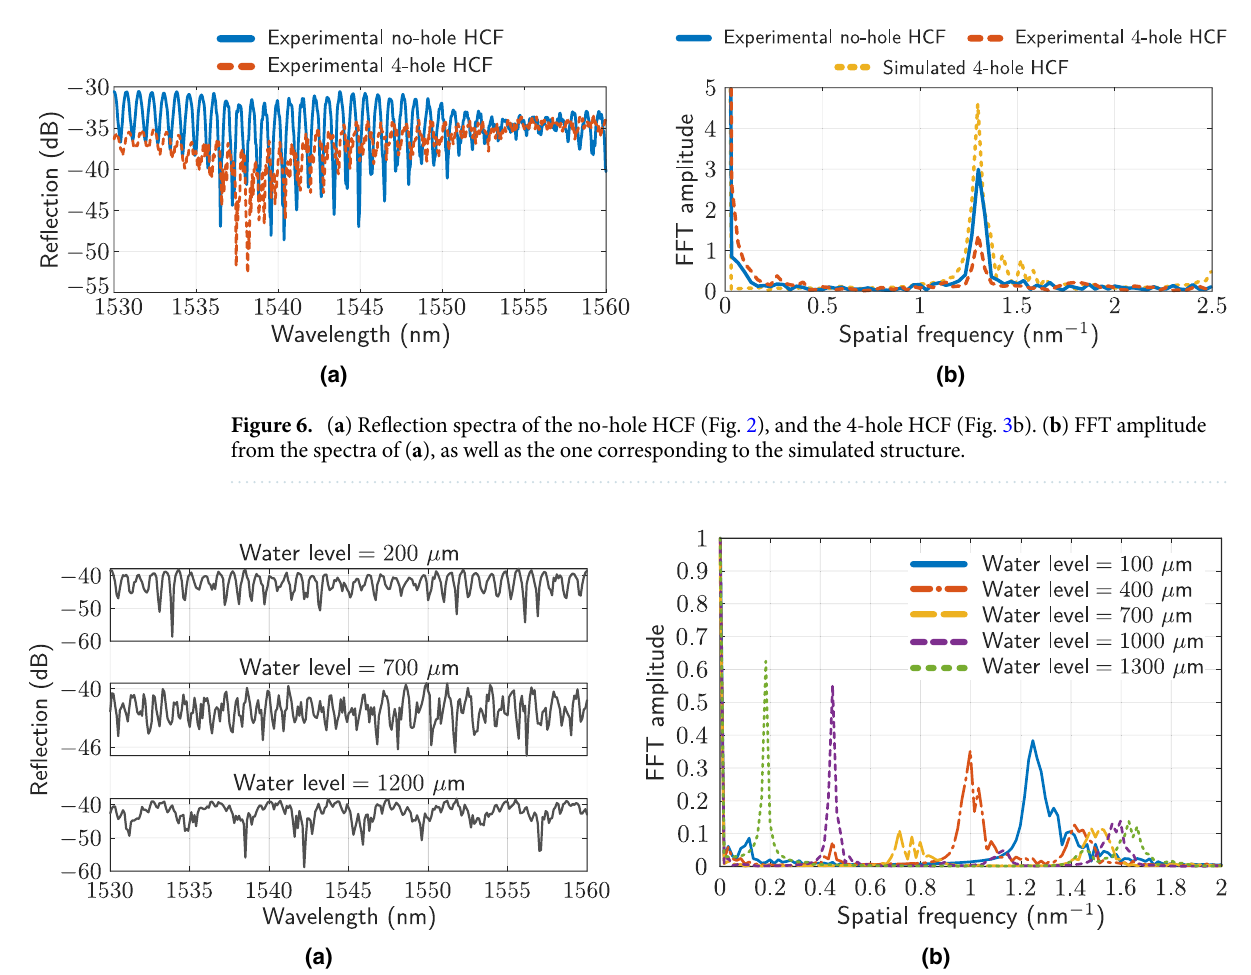
Figure 7. ( a ) Examples of measured reflection spectra for water levels of 200 µ m, 700 µ m and 1200 µ m, respectively.( b ) FFT amplitude of measured spectra corresponding to water levels of 100 µ m, 400 µ m, 700 µ m, 1000 µ m and 1300 µ